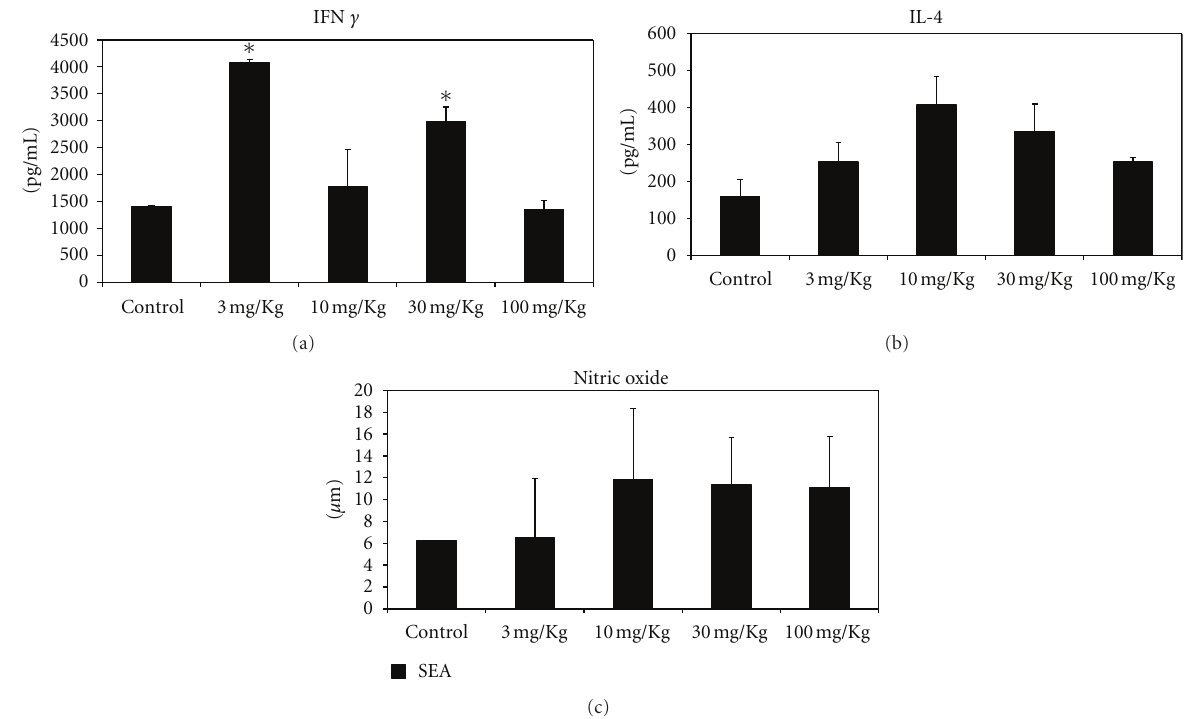
Figure 1: IFN- γ (a), IL-4 (b), and nitric oxide (c) production by spleen cells after treatment of S. mansoni -infected mice with LPSF-PT05- PEG. ∗ P < 0 . 001 in comparison with